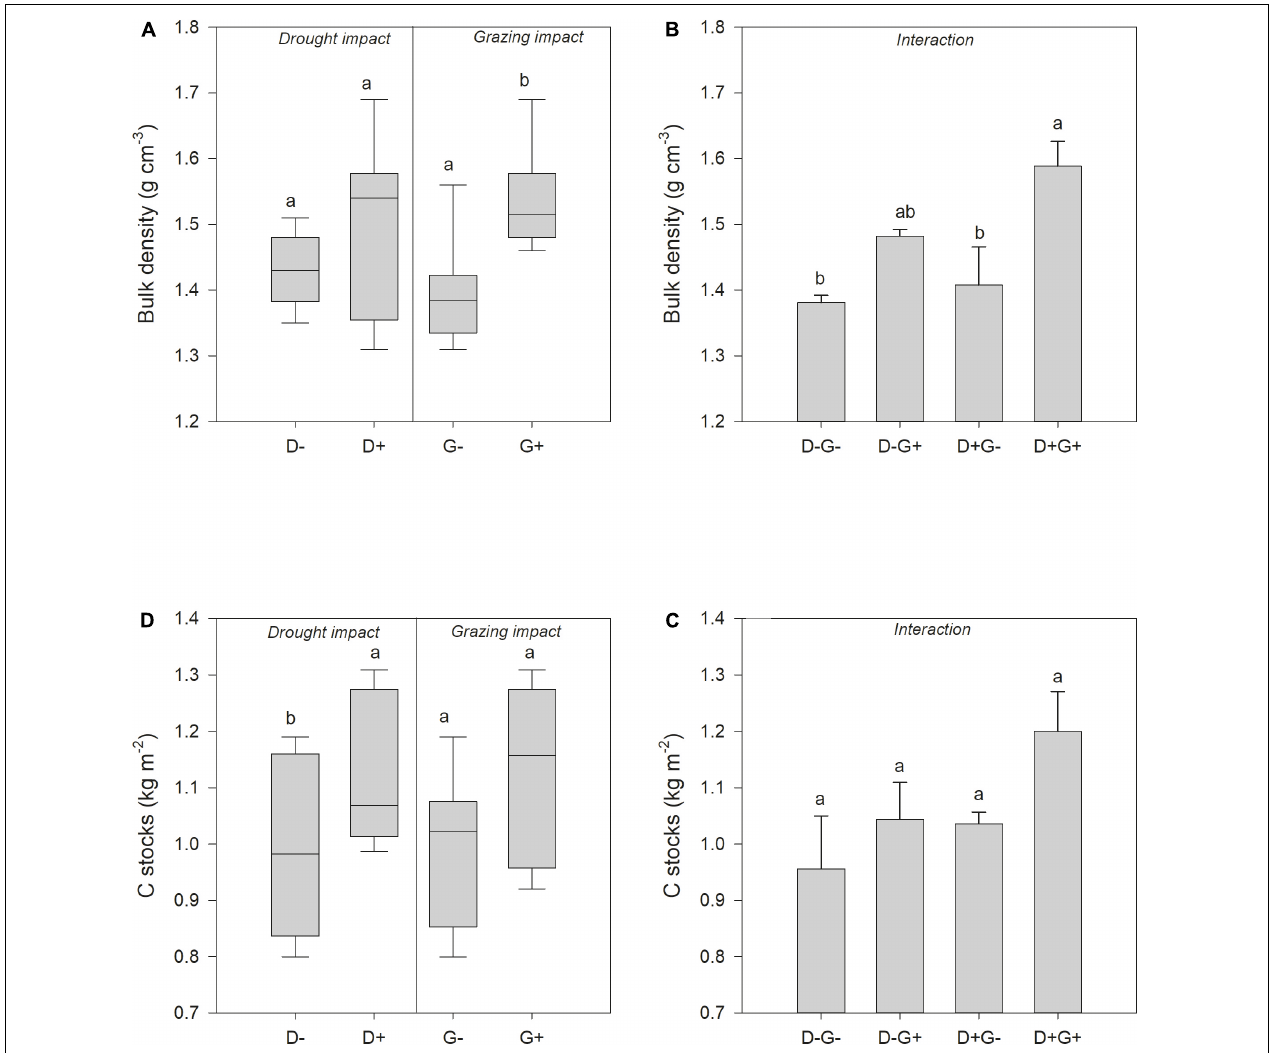
FIGURE 5 | Effect of drought and grazing on bulk density and C stocks. (A) The impact of the main effects (drought and grazing) on bulk density; (B) combined effect of drought and grazing on bulk density; (C) the impact of the main effects (drought and grazing) on C stocks; and (D) combined effect of drought and grazing on C stocks. Different lowercase letters indicate significant differences among treatments ( P <